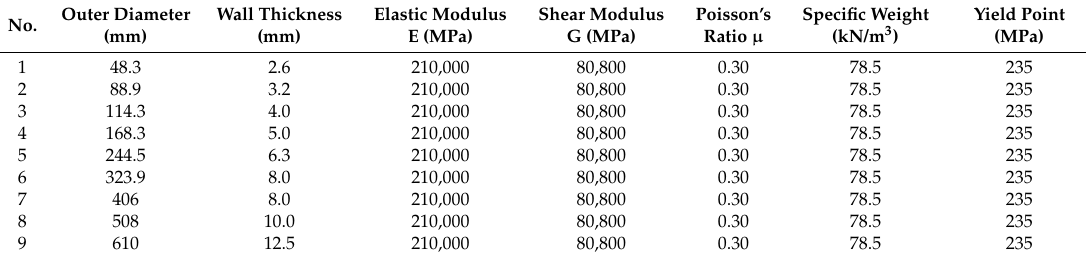
Table 7. Steel pipes [40–43].